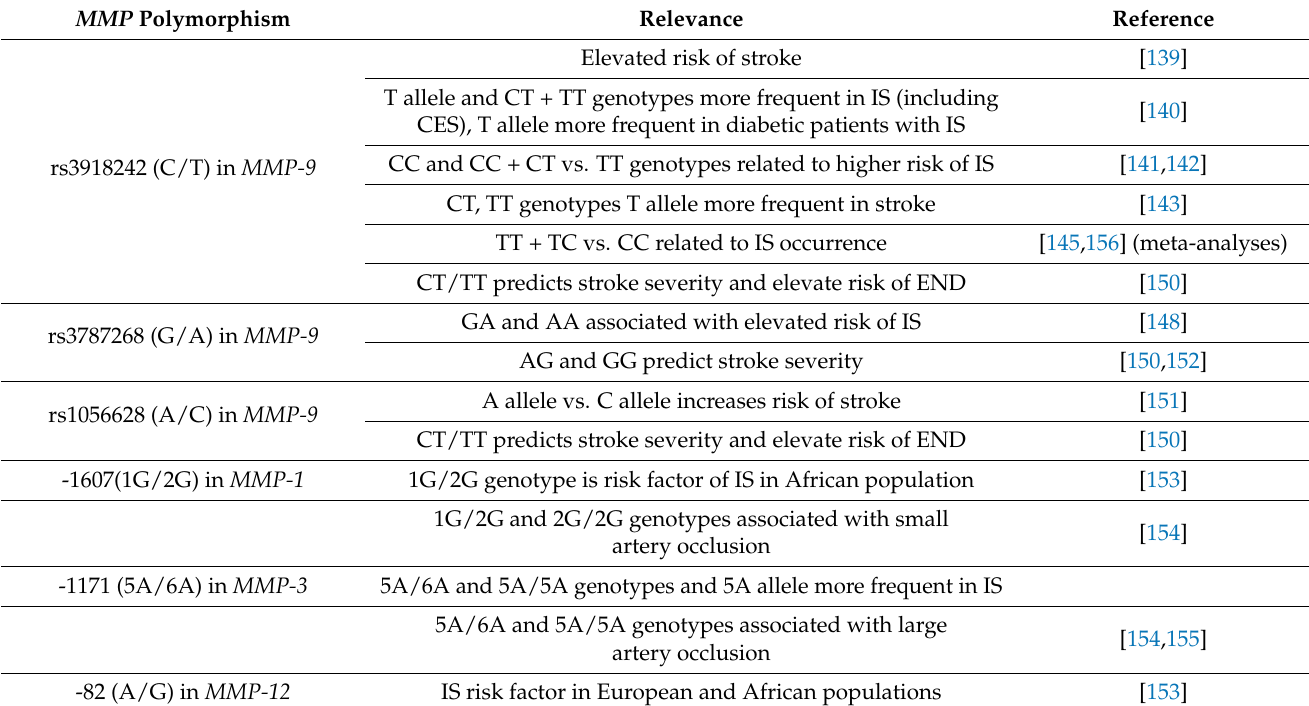
Table 1. Clinical relevance of MMPs polymorphisms in